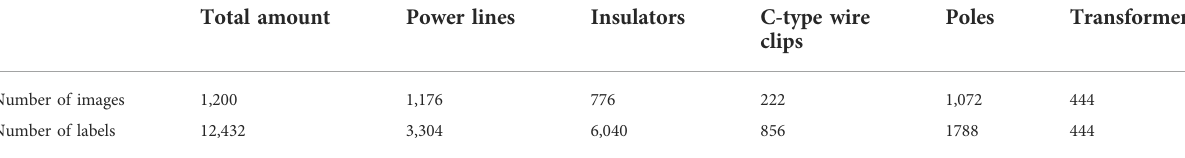
TABLE 1 Dataset